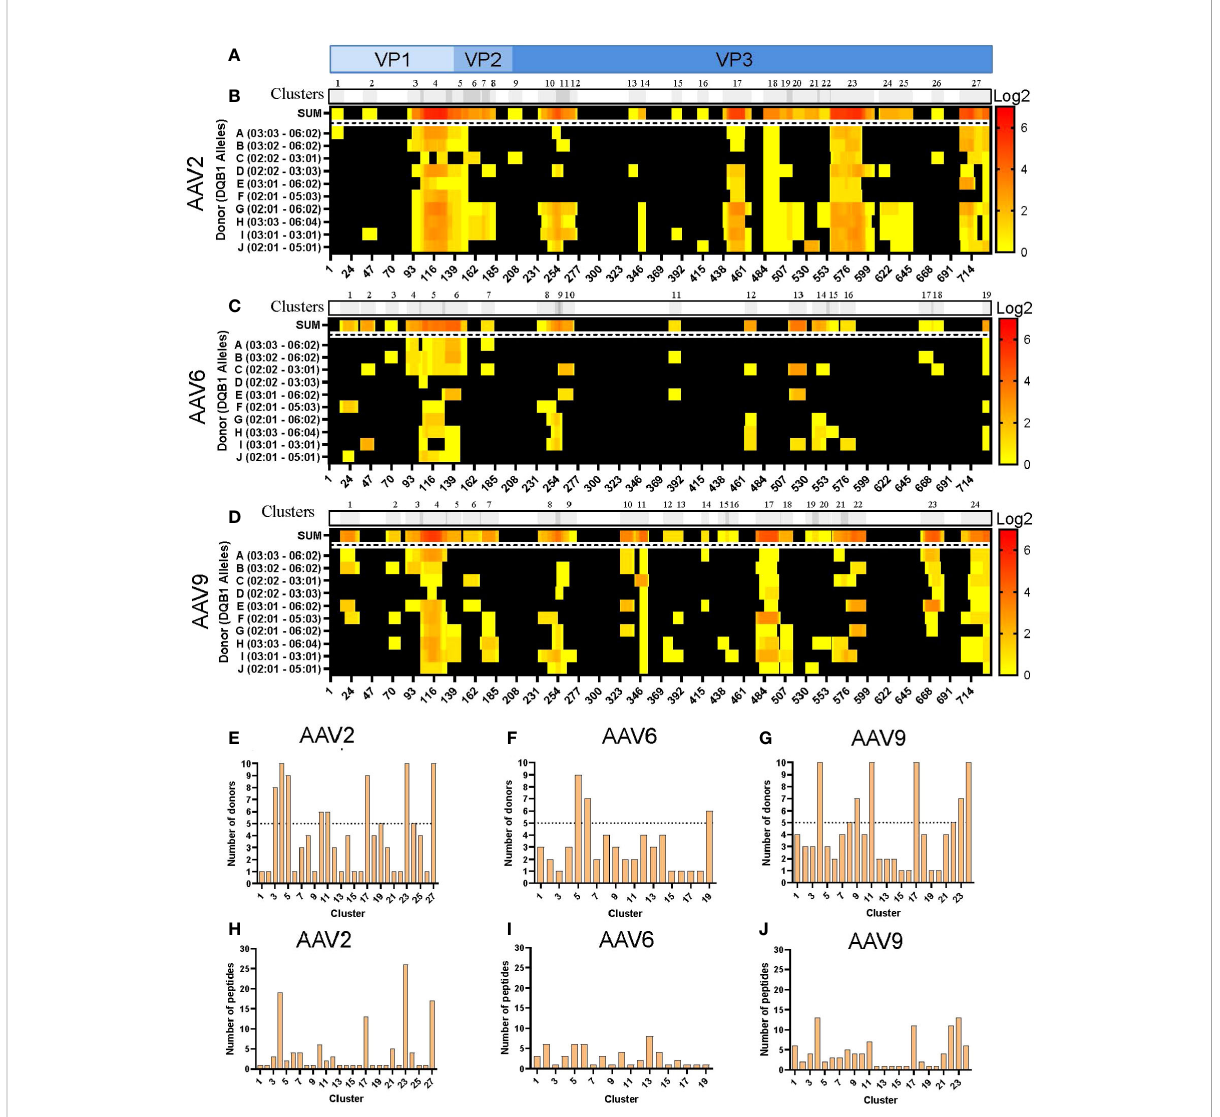
FIGURE 3 Differential levels of HLA-DQ display among AAV serotypes. (A) Diagram representation of the full-length sequence of VP1, highlighting the regions that correspond to the VP1, VP2 and VP3 regions. (B – D) MAPPs peptide representation of AAV2 (B) , AAV6 (C) and AAV9 (D) . Aligned HLA-II peptides are displayed as heatmaps where: the fi rst row (in grey) represents the peptide clusters, identi fi ed by IEDB Epitope Cluster Analysis Tool 1.0. Overlapping sections of peptide clusters are shown as darker grey; the second row, shown as “ SUM, ” represents peptides summed where each amino acid is shown as the intensity relative to the number of times it was seen on the identi fi ed peptide sequences; rows 3 to 12 represent each of the donors and their DQB1 alleles. Peptide intensity in SUM and the donor rows are shown in log2 scale, where black represents no peptide presentation and red the most presentation of peptides in a particular region. At the bottom of each heatmap, the amino acid residue position is indicated. (E – G) Bar graphs showing the number of donors presenting at least one peptide from each cluster AAV2 (E) , AAV6 (F) and AAV9 (G) . The cluster numbering as in B-D is represented on the X-axis and the number of donors is shown in the Y-axis. The dotted lines represent the cutoff for “ public ” clusters. (H – J) Bar graph representing the number of peptides per cluster for AAV2 (H) , AAV6 (I) and AAV9 (J) . Clusters are denoted in the text by the serotype + HLA + cluster number, e.g.